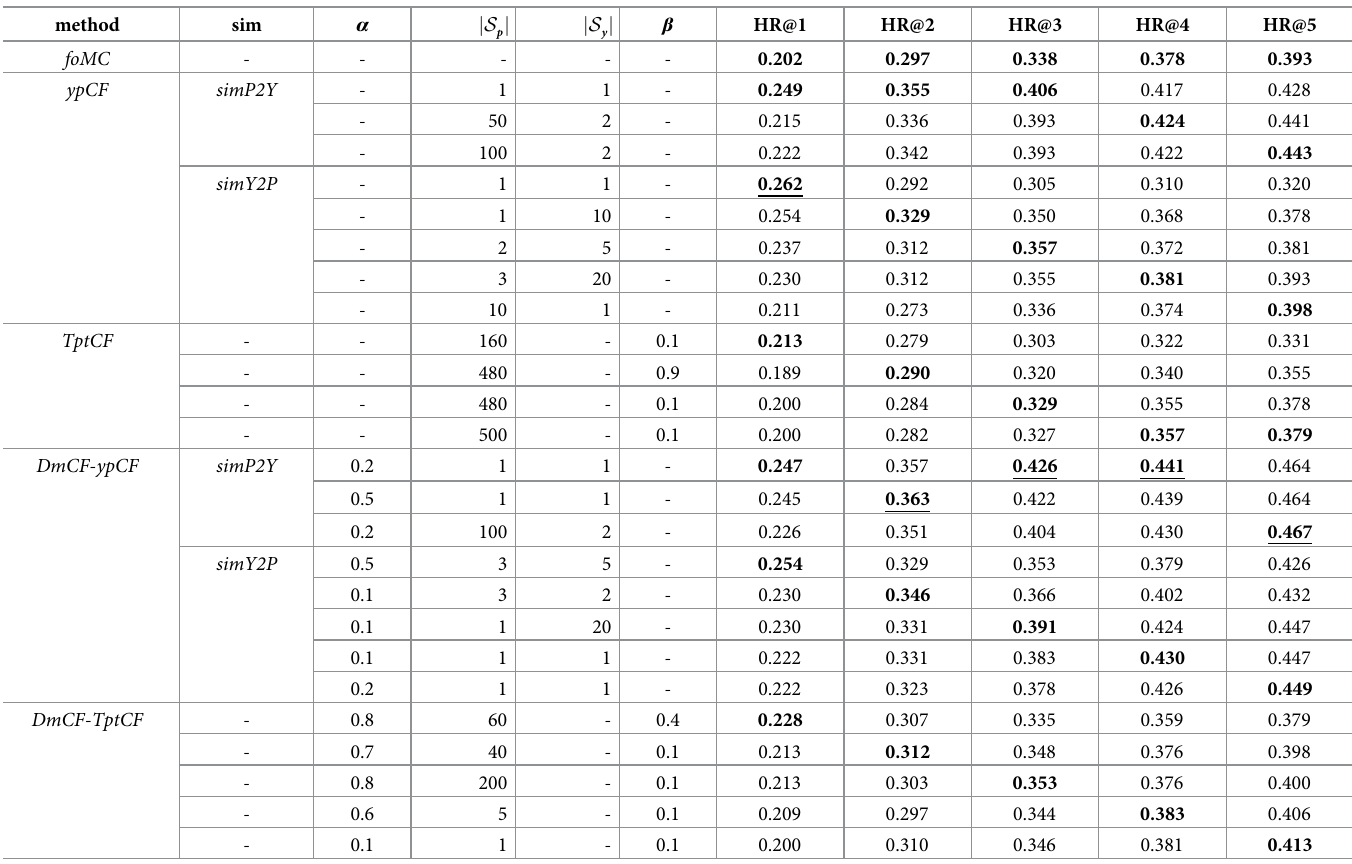
Table 4. Overall performance of all methods for CUTOFF